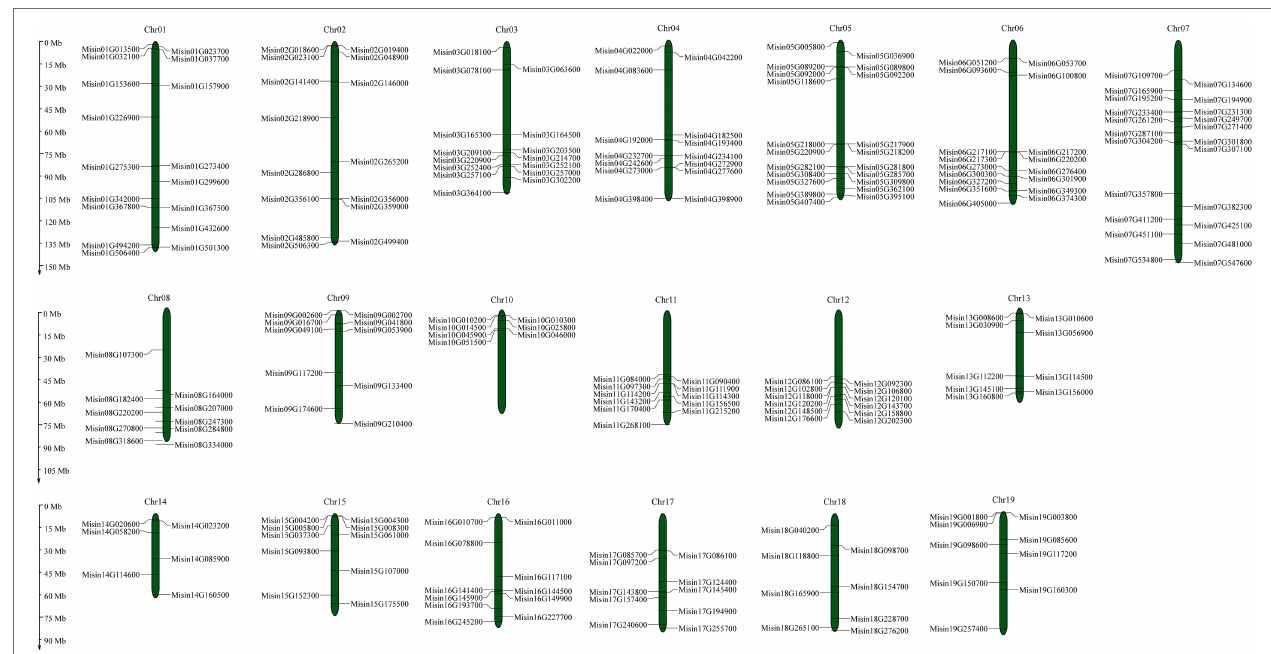
FIGURE 3 | Distribution of 234 M. sinensis NAC genes on 19 chromosomes. Vertical bars represent the chromosomes, and the chromosome number is to the top of each chromosome. The scale on the left represents chromosome length